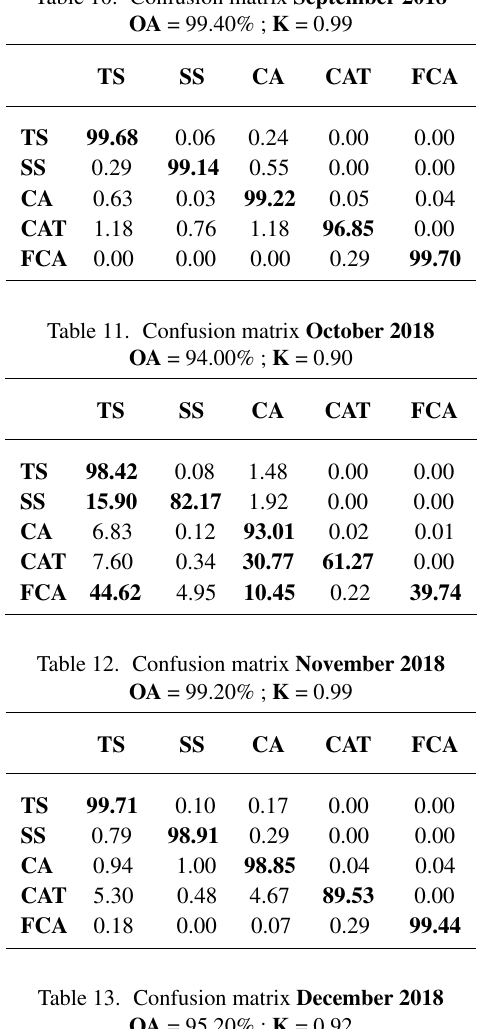
Table 5. Confusion matrix April 2018